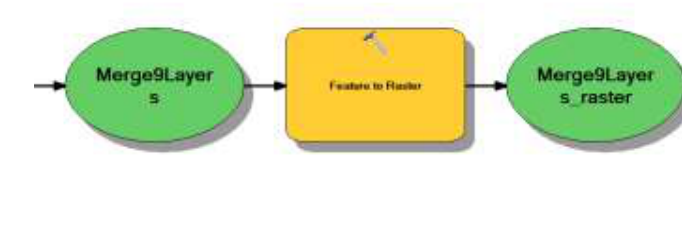
Figure 2: Conversion of vector layers to